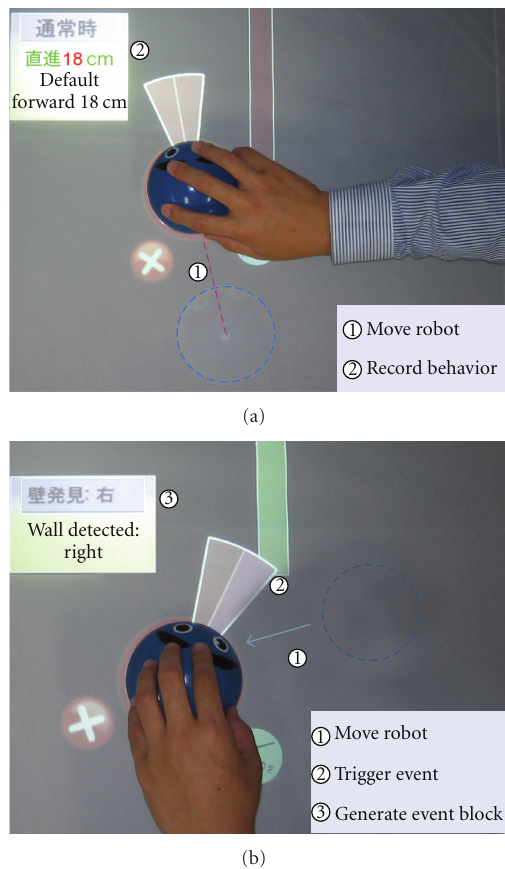
Figure 7: ExploreRobot: definition of motion path (a) and defini- tion of event (b).